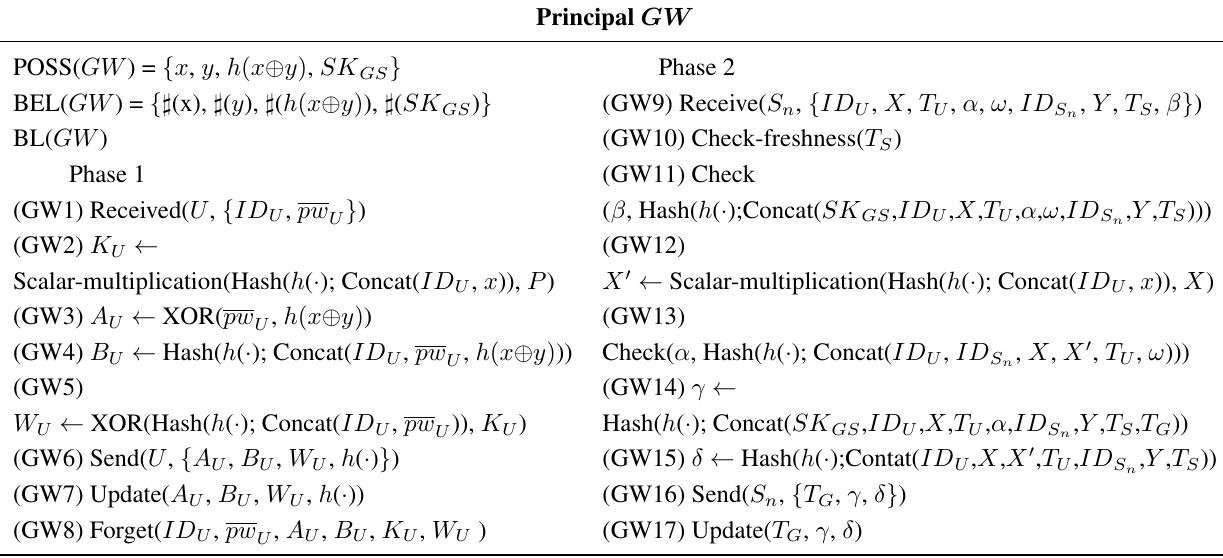
Table 8. Local sets specification for principal GW